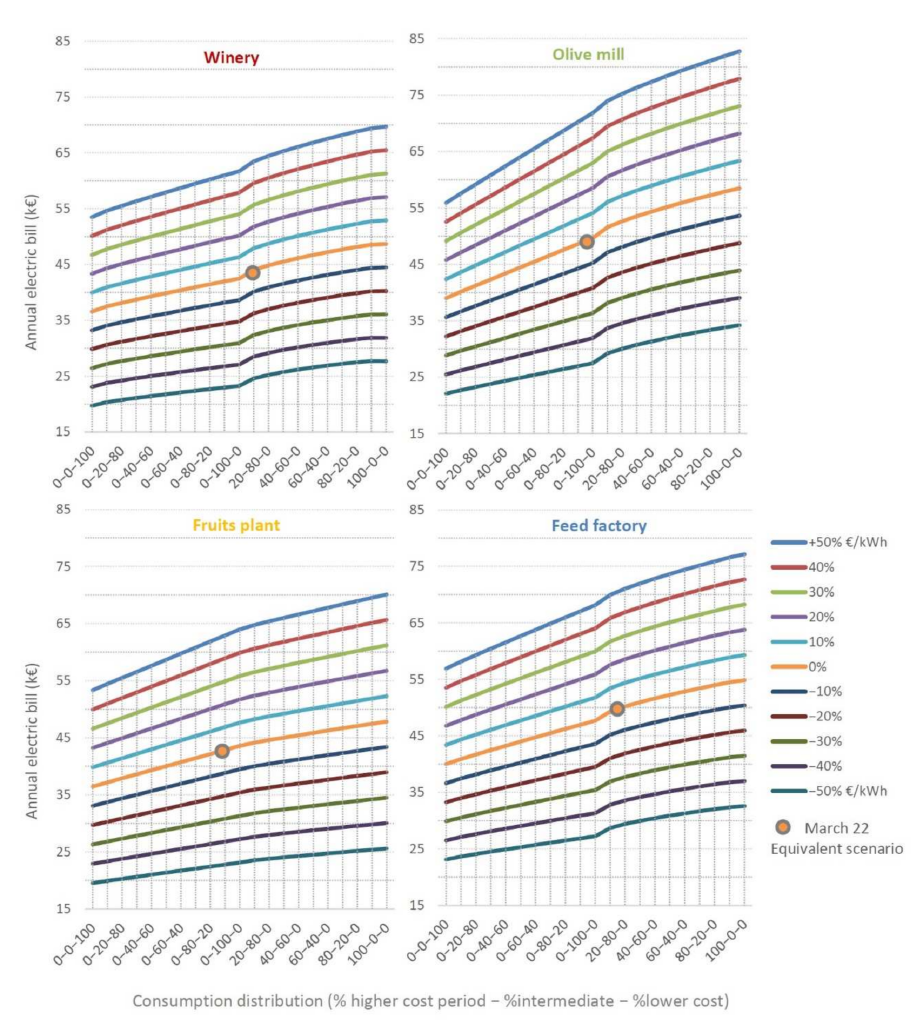
Figure 8. Annual electricity bill in scenarios with different consumption distribution (% in the lowest cost period, % in the intermediate period, and % in the high-cost period). For each reference scenario, the variation in the price of the energy term is